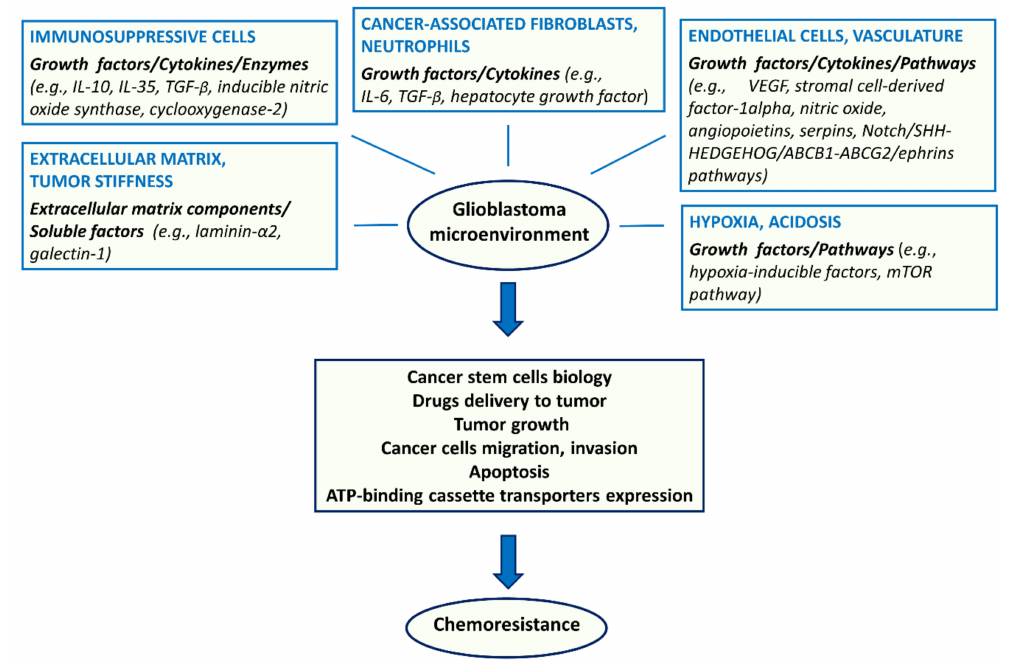
Figure 1. Schematic representation of the main components (endothelial cells, vasculature, immunosuppressive cells, CAFs, neutrophils, ECM, tumor stiffness, hypoxia, acidosis) and molecules of glioblastoma microenvironment involved in chemoresistance. Glioblastoma microenvironment, interacting with CSCs and influencing other mechanisms associated with cancer, promotes